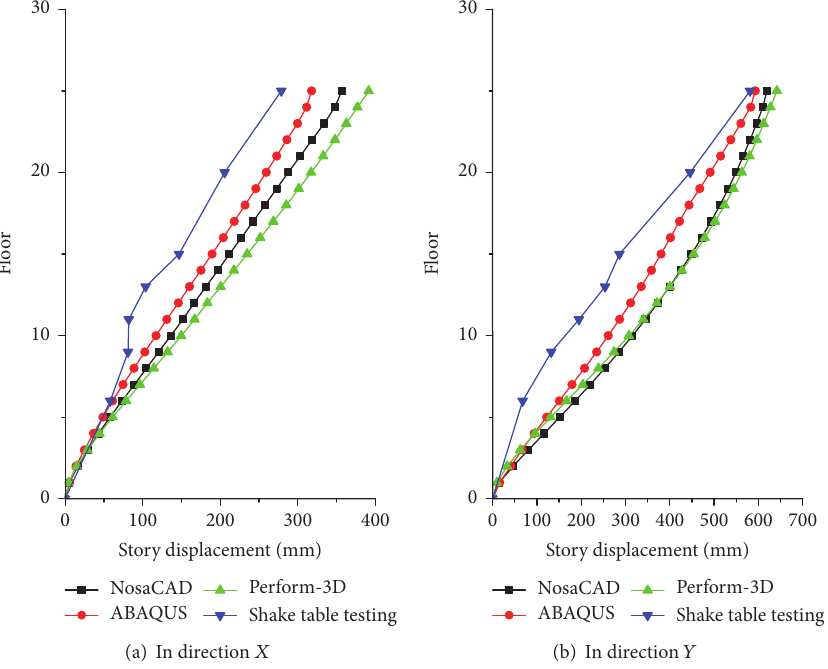
Figure 18: Story displacement envelopes under rare intensity 7